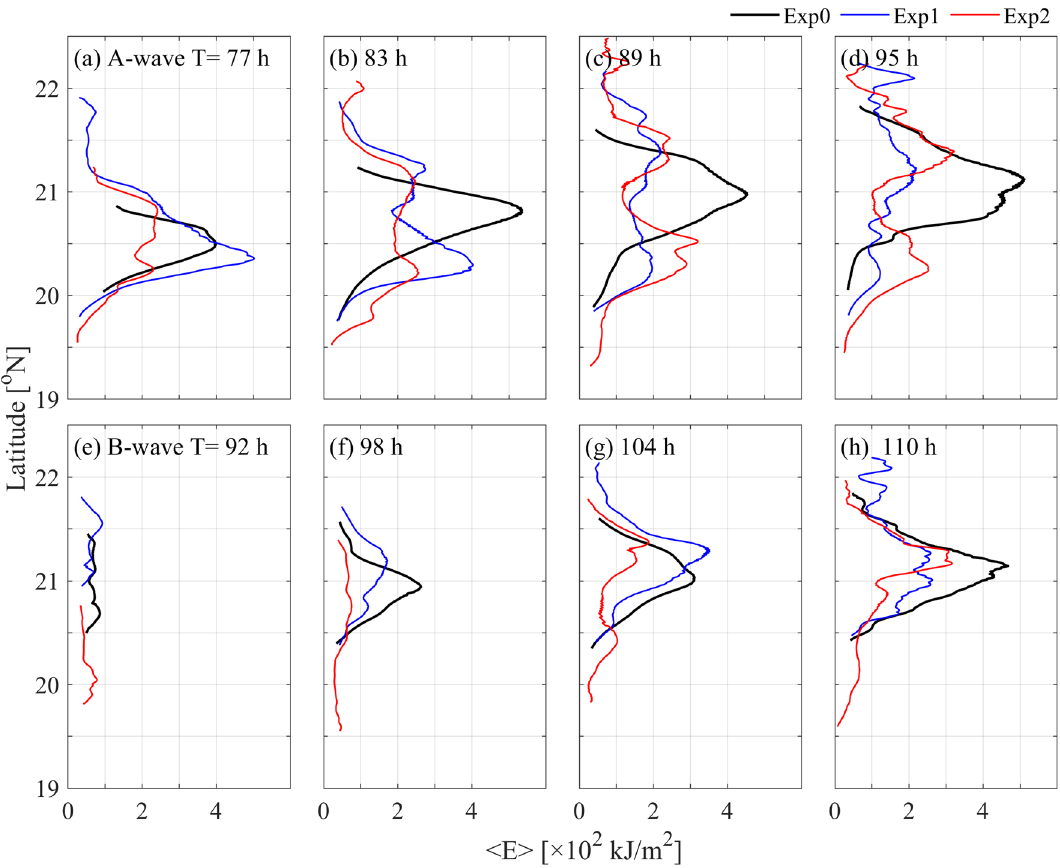
Figure 9. Meridional distribution of energy for ( a–d ) the A-wave and ( e–h ) B-wave at different